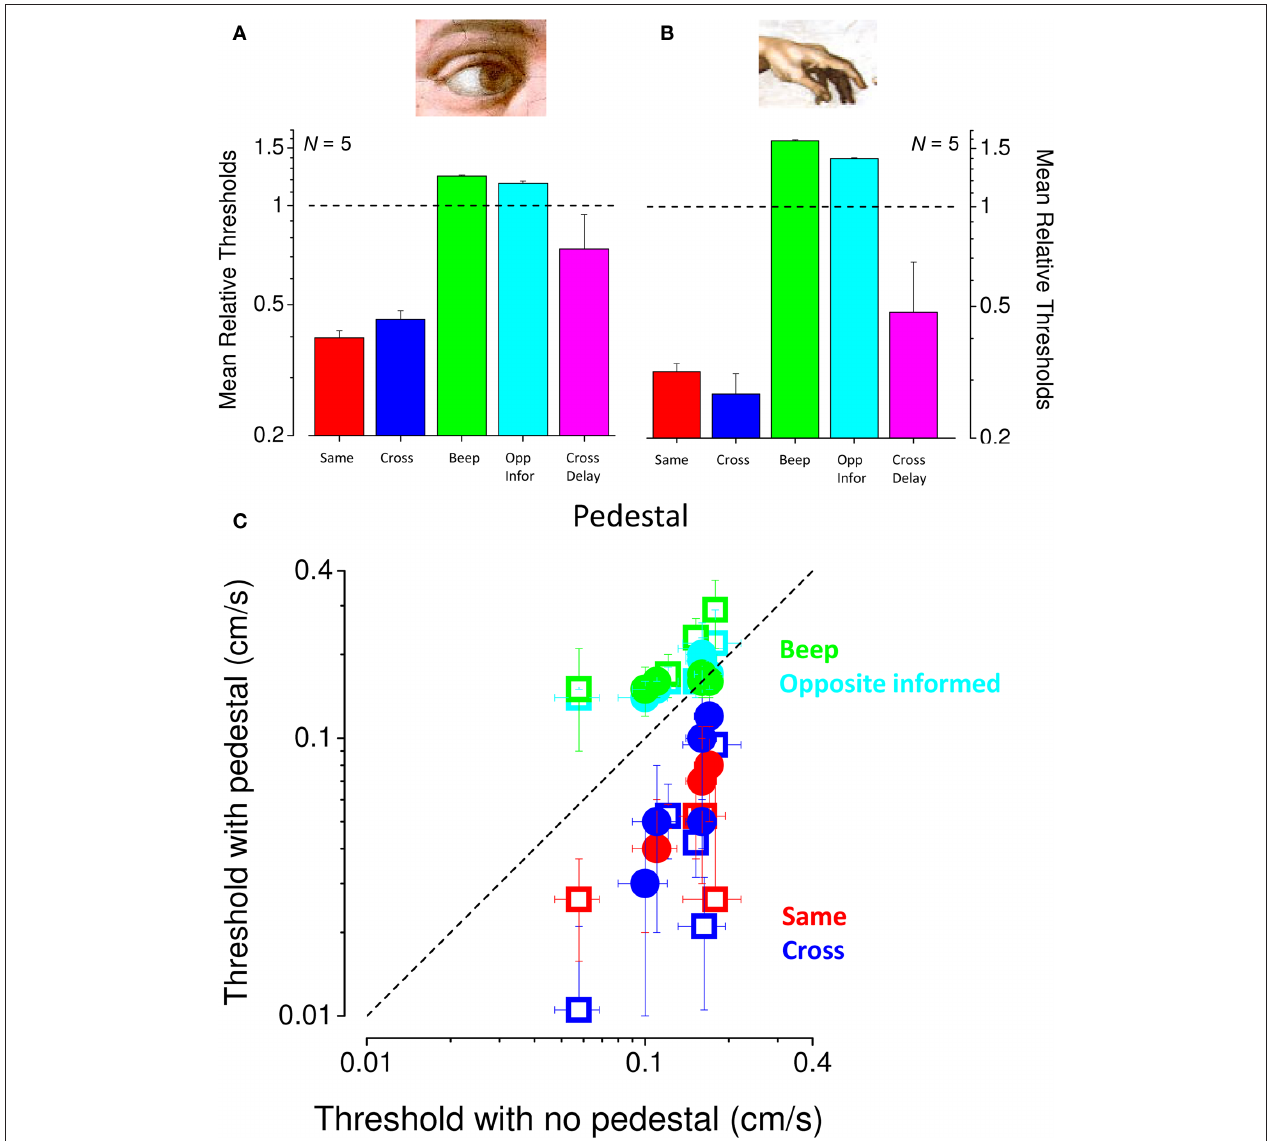
auditory tone of 2450 Hz, and the cyan bar thresholds opposite directions of motion (observers were informed of the inversion). Pink bars indicate thresholds for pedestal signal of the other modality delayed of 100 ms (measured in three subjects). (C) Individual thresholds for speed increment discrimination, plotted against no-pedestal thresholds. Visual thresholds are shown by closed symbols, tactile by open symbols (color coding as above). Error bars on individual data points were obtained by bootstrap (Efron and